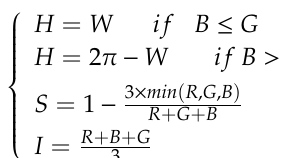
Figure 2. The camera motion rectification between t and t + 1 frames.